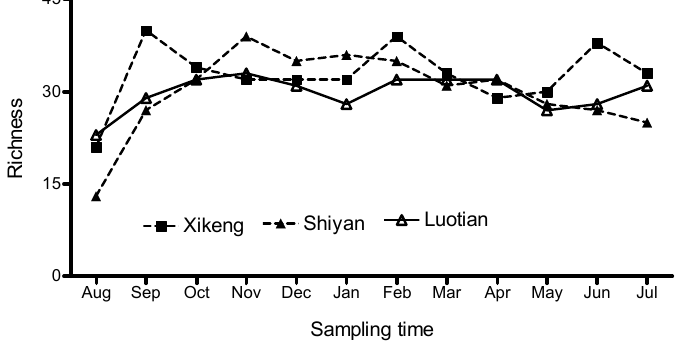
Figure 5. Bacterioplankton richness in the three reservoirs. The number of DGGE bands per gel is regarded as a representation of richness.